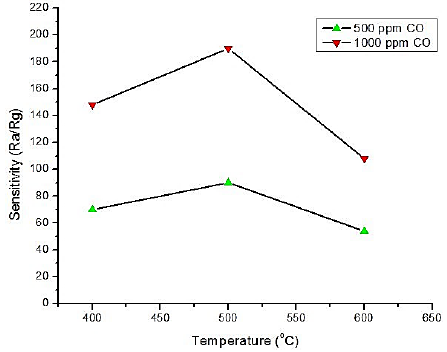
Figure 10. Effect of calcination (in N 2 ) temperature on Pt-SnO 2 to 500 and 1000 ppm CO gas. Yuasa et al. [61] developed another palladium oxide (PdO) doped with SnO 2 nanoparticles